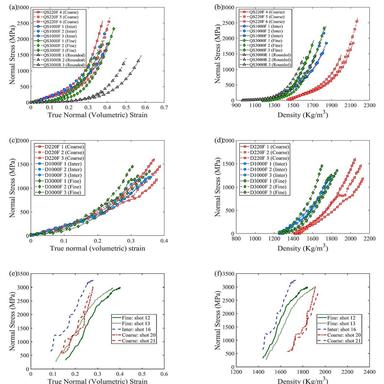
Normal constitutive behavior of granular boron carbide: (a) normal stress vs. strain curves and (b) normal stress vs. density curves at quasi-static loading rate. (c) and (d) are the same curves under dynamic Kolsky bar compaction. (e) and (f) are those for the normal plate impact condition. Note that the green, black, blue and red curves correspond to fine (3000F), rounded (3000R), intermediate (1000F) and coarse (220F) powder respectively. Specific test names are used in the legends. (For interpretation o